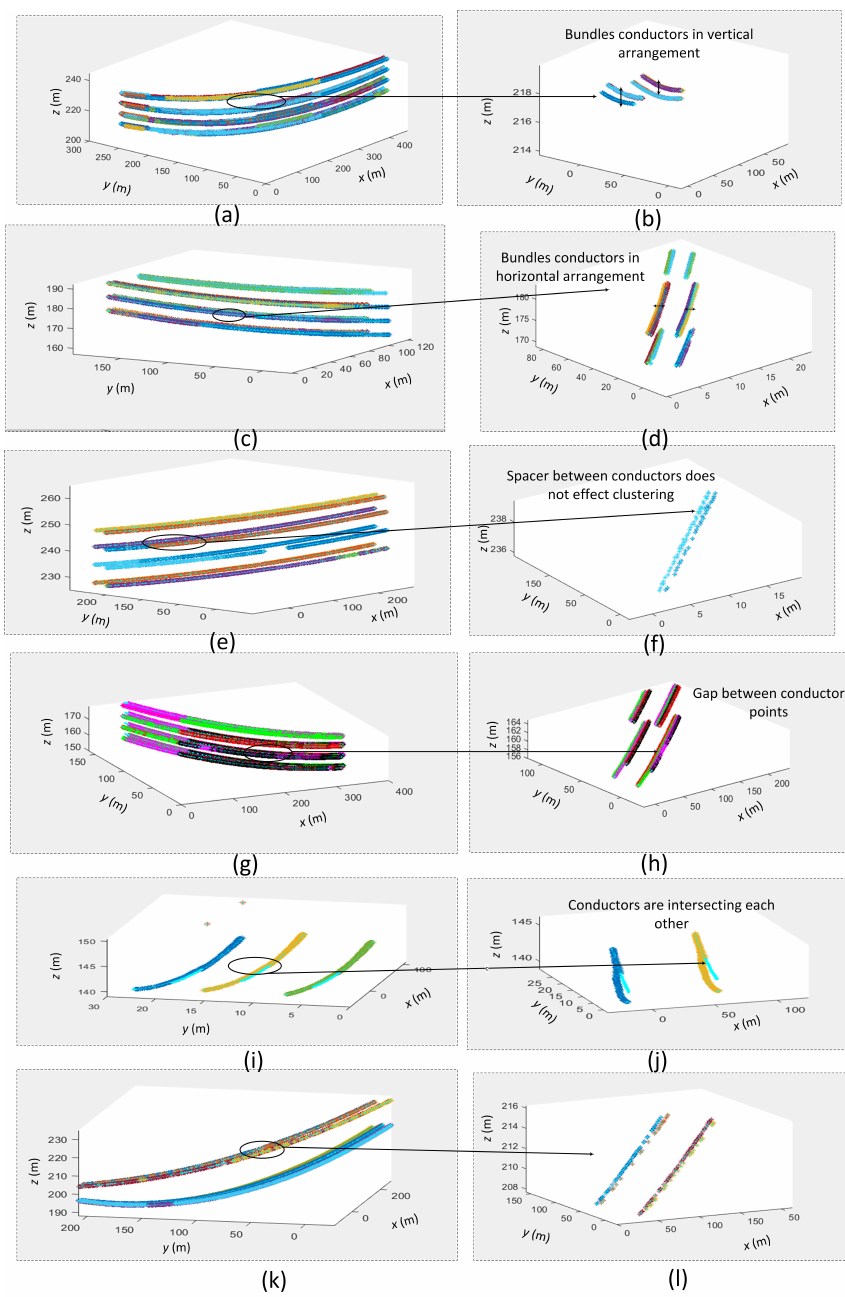
Figure 13. Extraction of individual conductors at the Bindebango (BDB) site. In panel ( a ) the origin (0, 0) represents (5.155 × 10 5 , 6.9218 × 10 6 ), in panel ( b ) the origin (0, 0) represents (5.159 × 10 5 , 6.9218 × 10 6 ), in panel ( c ) the origin (0, 0) represents (5.145 × 10 5 , 6.92255 × 10 6 ), in panel ( d ) the origin (0, 0) represents (5.147 × 10 5 , 6.92255 × 10 6 ), in panel ( e ) the origin (0, 0) represents (5.1545 × 10 5 , 6.92168 × 10 6 ), in panel ( f ) the origin (0, 0) represents (5.1546 × 10 5 , 6.92168 × 10 6 ), in panel ( g ) the origin (0, 0) represents (5.147 × 10 5 , 6.92178 × 10 6 ), in panel ( h ) the origin (0, 0) represents (5.149 × 10 5 , 6.92178 × 10 6 ), in panel ( i ) the origin (0, 0) represents (5.141 × 10 5 , 6.9227 × 10 6 ), in panel ( j ) the origin (0, 0) represents (5.143 × 10 5 , 6.9227 × 10 6 ), in panel ( k ) the origin (0, 0) represents (5.151 × 10 5 , 5.9219 × 10 6 ) and in panel ( l ) the origin (0, 0) represents (5.153 × 10 5 , 5.9219 × 10 6